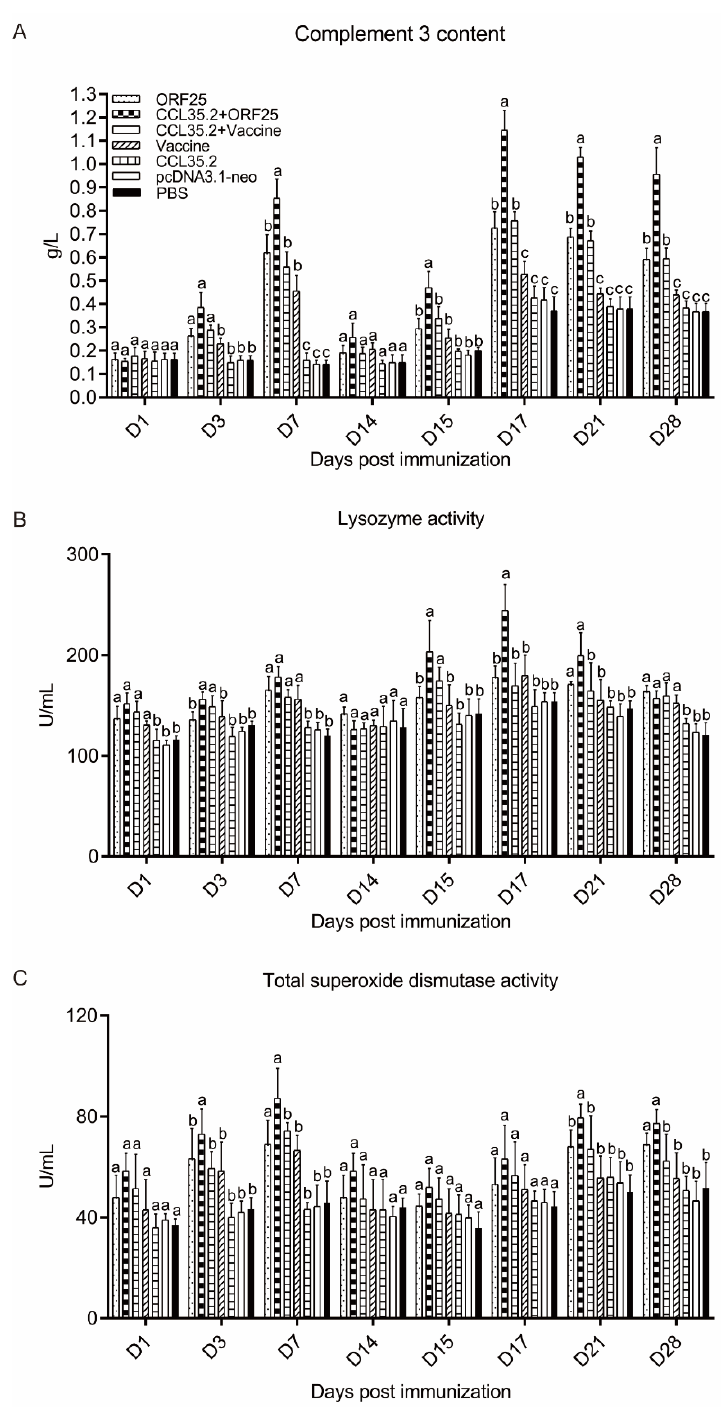
Figure 6. Serum innate immune indices. Complement 3 ( A ), lysozyme ( B ) and total superoxide dismutase ( C ) were determined by the commercial kits (Nanjing Jiancheng Bioengineering Institute, Nanjing, China). Different superscript letters in each group (a–c) denote significant variations suggested by the Kruskal–Wallis statistics at 95% of significance, followed by the Dunn test with Bonferroni adjustment as the post hoc test ( p < 0.05).